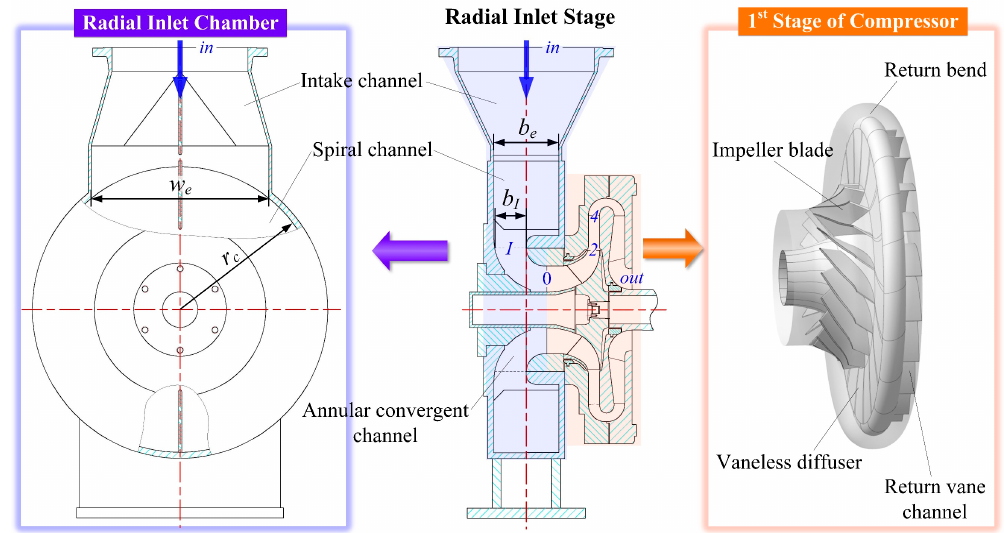
Figure 1. Schematic diagram of the radial inlet chamber and the compressor stage. Table 1. Major geometric parameters of the radial inlet chamber and the compressor stage.